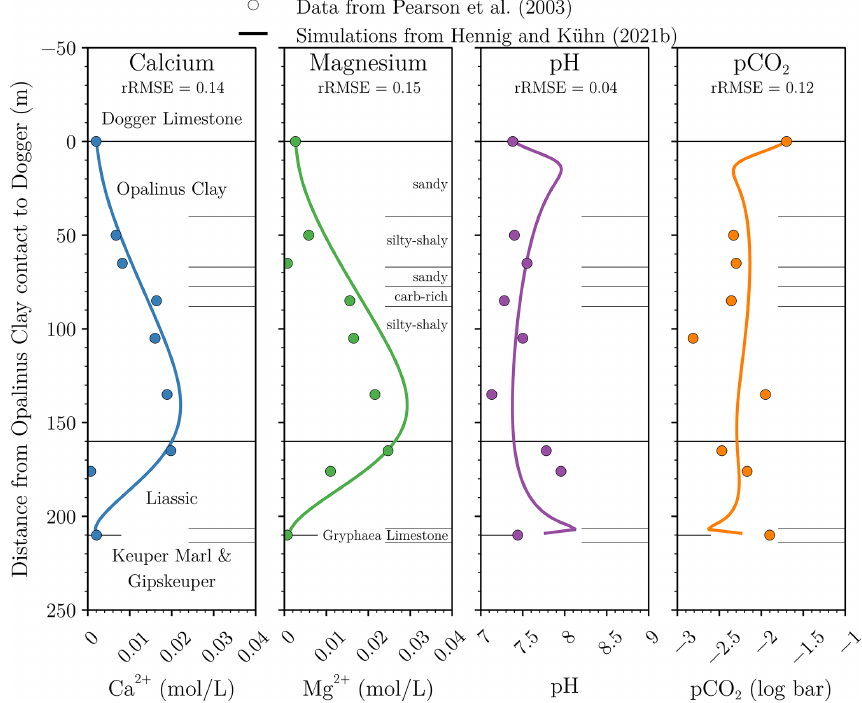
Figure 1. Concentrations of pore water components decrease within the CPRZ (Opalinus Clay and Liassic Shales) towards embedding aquifers in the Liassic and Dogger. Initial geochemical conditions in the investigated system are represented by simulations of the hydroge- ological system of the Opalinus Clay at Mont Terri conducted by Hennig and Kühn (2021b). Calcium, magnesium, pH and p CO 2 are the governing parameters for uranium speciation, and thus exemplary shown for the other pore water components. Deviations between modelled and measured data are given by the relative Root Mean Square Errors (rRMSE). Modified from Hennig and Kühn